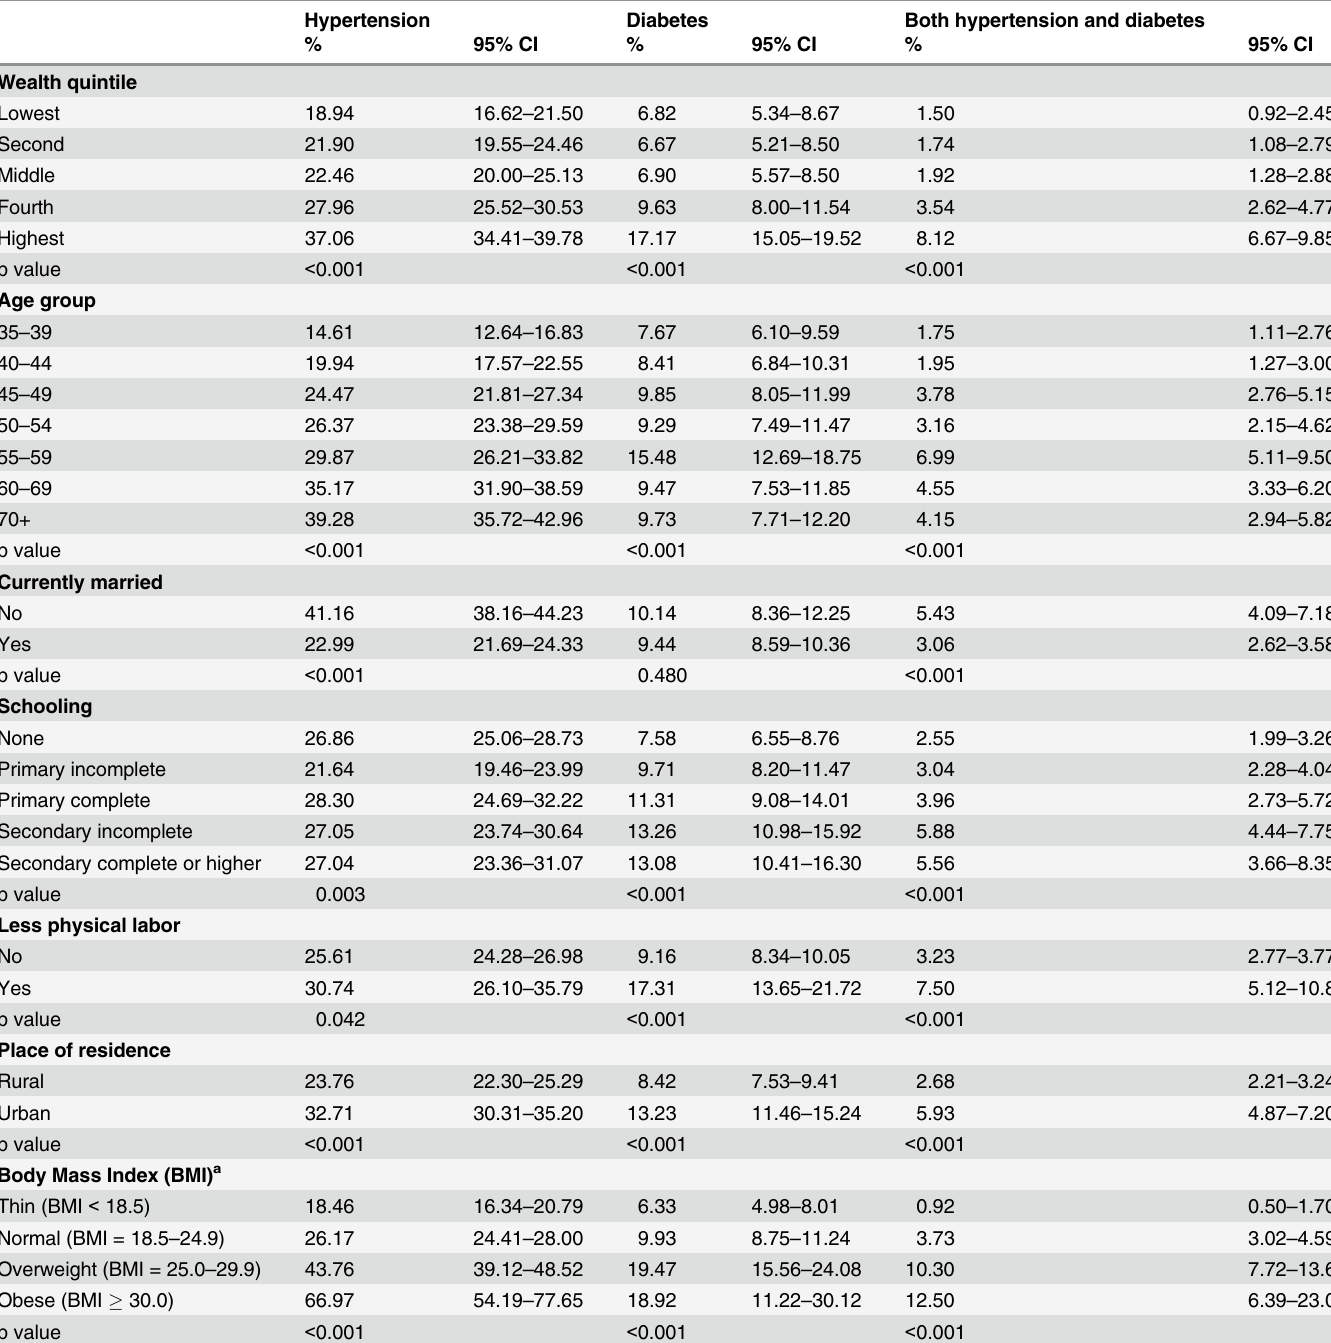
Table 2. Percent of individuals having hypertension, diabetes and the coexistence of hypertension and diabetes by socio-demographic character- istics (N = 7499). Hypertension